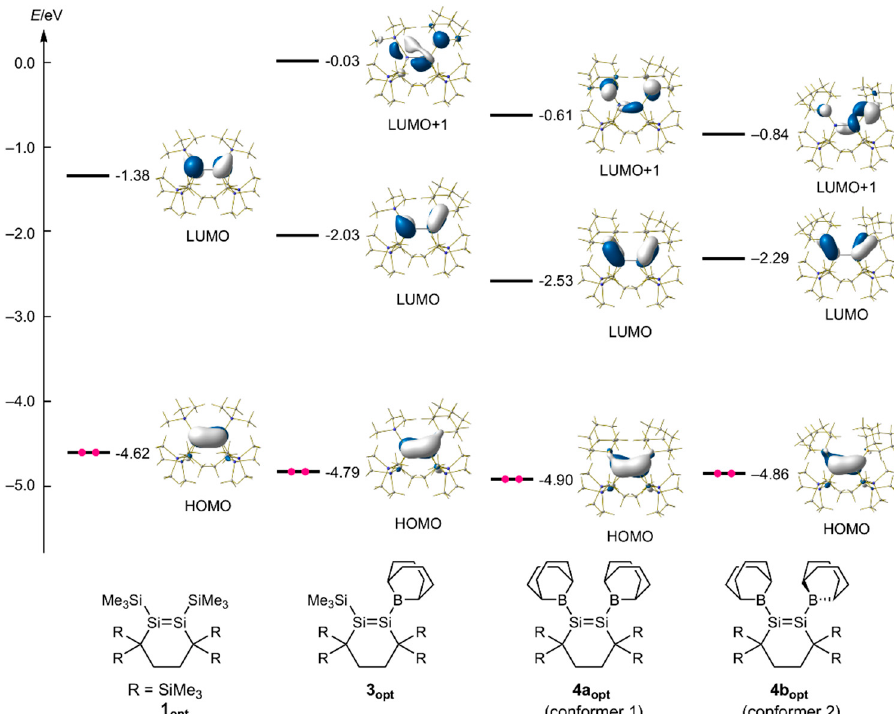
Figure 5. Frontier Kohn–Sham orbitals and their energy levels of 1 opt , 3 opt , 4a opt , and 4b opt calculated at the B3LYP-D3/B1 level of theory (B1: 6-311G(2df) [Si], 6-311G(d) [N, C, B, H]) (R = SiMe 3 ).